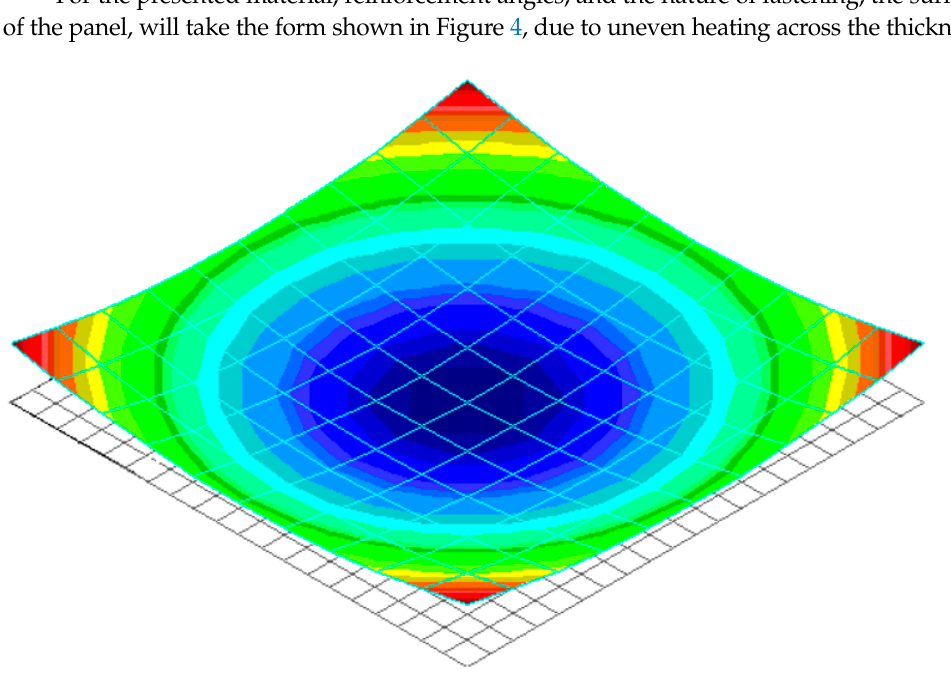
Table 1. Dependence of maximum deflection (mm) of the panel on the heating rate. Figure 4. General view of deflection of the panel with symmetric reinforcement structure because of uneven heating across the thickness.